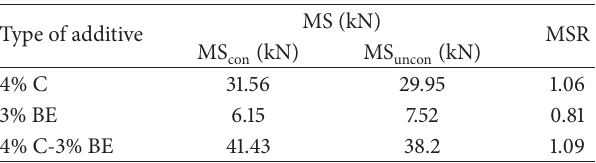
Table 5: Results of MSR of conditioned and unconditioned speci- mens.